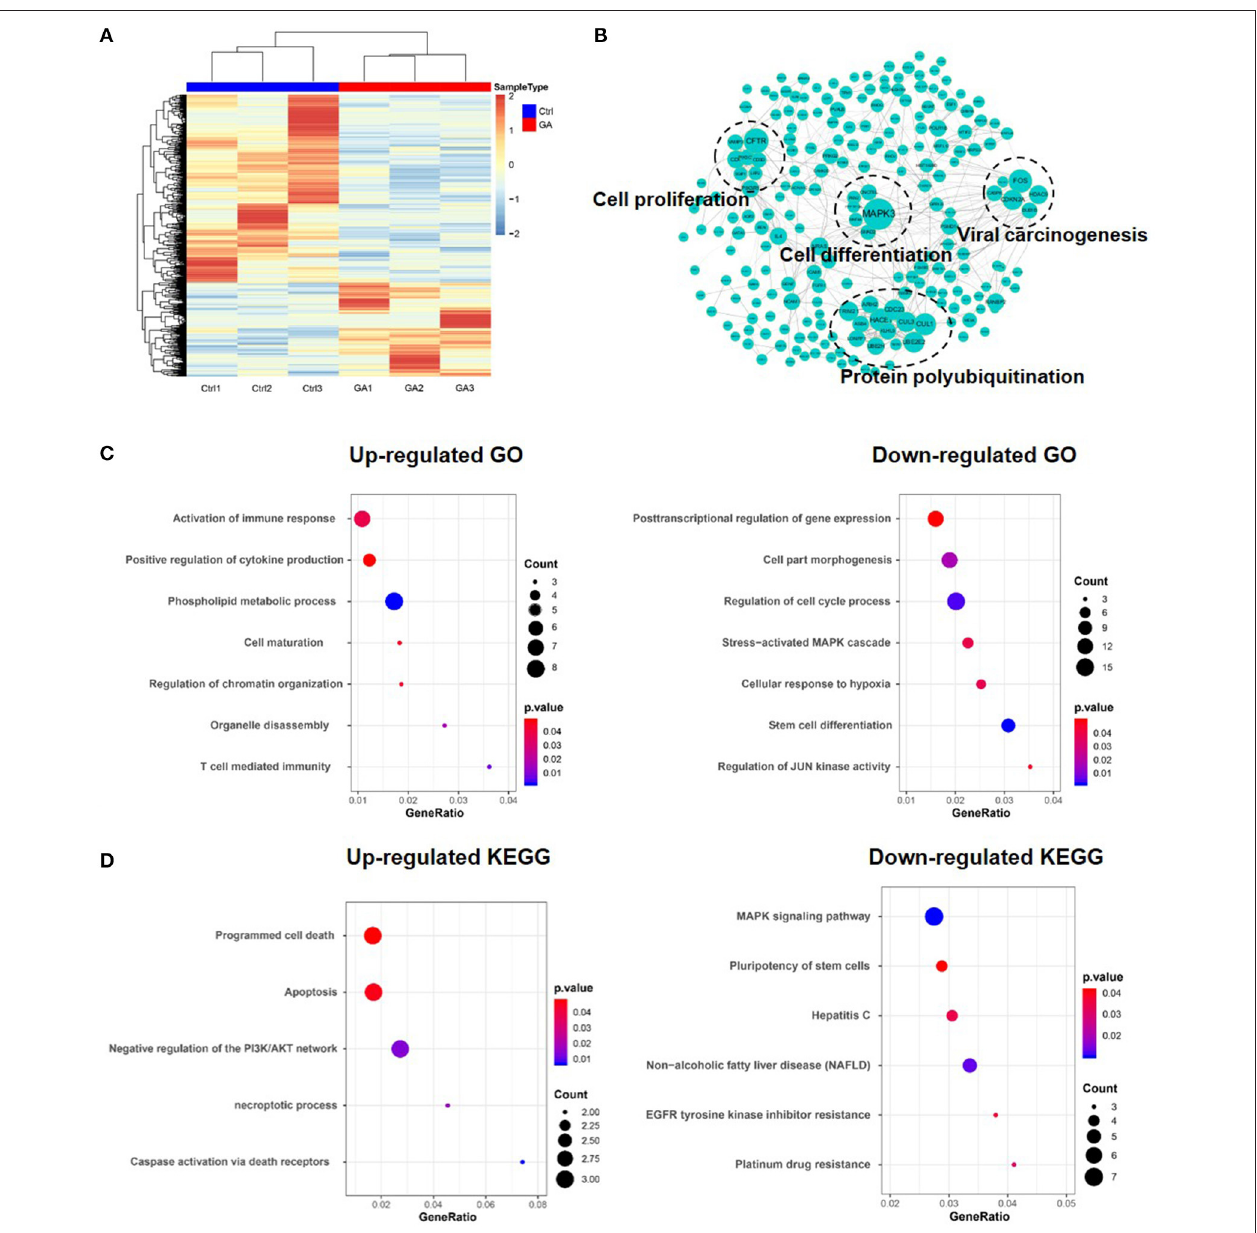
FIGURE 2 | Multiple functions in HCC were affected after treatment with GA. (A) Heat map of the differential gene expression profile in HepG2 cells after GA treatment. (B) Functions were analyzed using Metascape and shown in Cytoscape. (C) GO analysis of up-regulated and down-regulated genes. (D) KEGG analysis of up-regulated and down-regulated